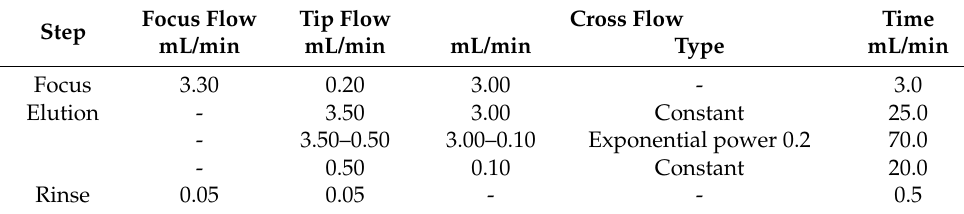
Table 7. Elution parameters for the AF4-UV-MALS